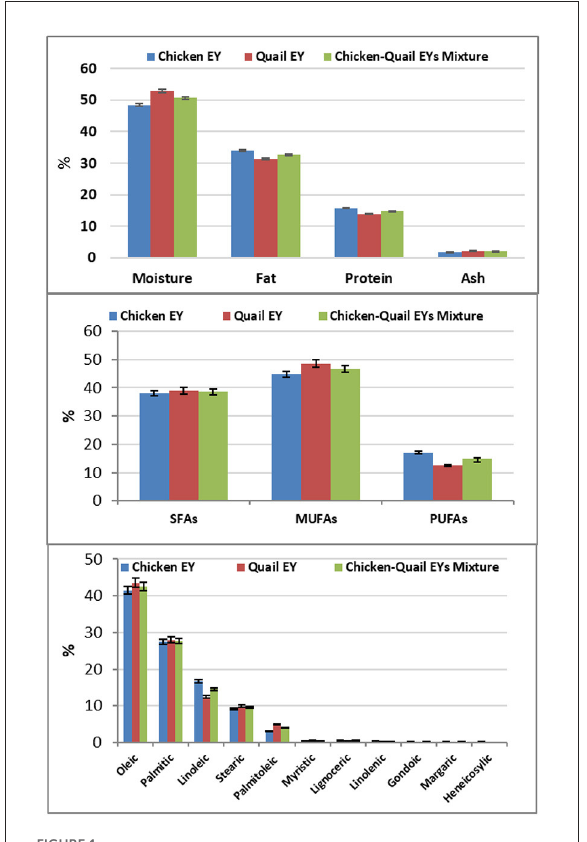
FIGURE1 The component and fatty acids of chicken and Japanese quail egg yolk (EY) and their mixture